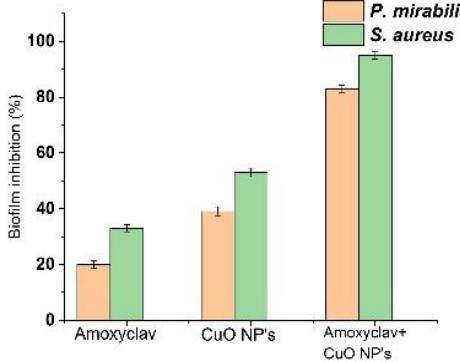
Figure 5. Inhibition of biofilm formation by amoxyclav and CuO NPs.